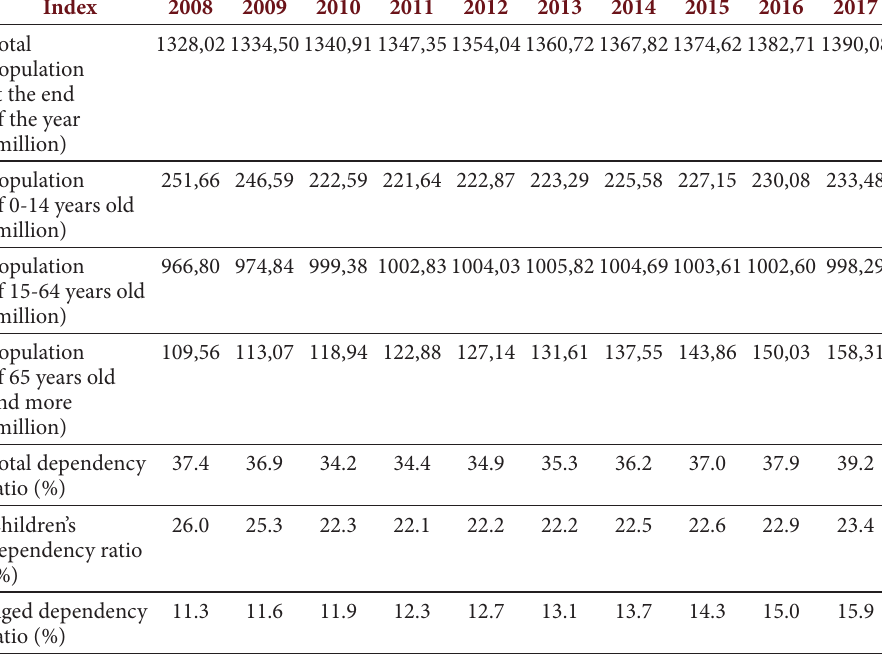
Table 4: The age structure and dependency ratio of the population (2008–2017).